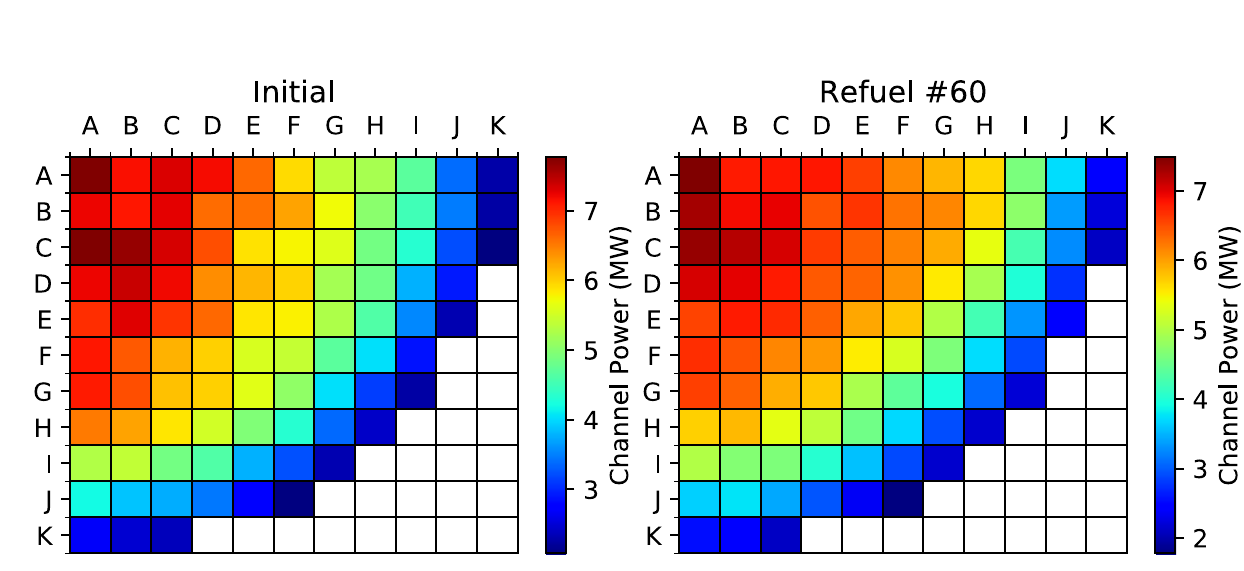
Figure 2: Power Profile Generated from Integrated Channel Powers for the Initial Burn Loading in Table 2 (left) and after 60 Channel Refuelings (right) Illustrating the Profile Smoothing Achieved from